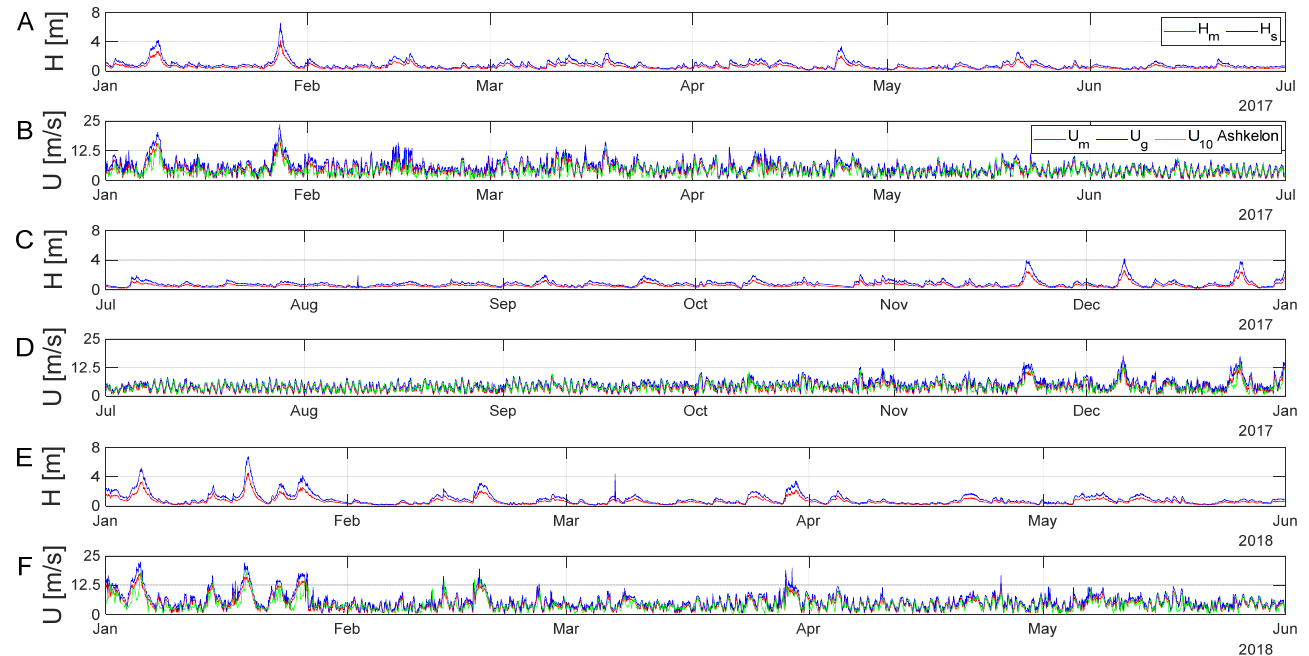
Figure 1. ( A ) 2017 January–June, significant and mean wave height hourly variations; ( B ) 2017 January–June, wind speed U, wind gusts and Ashkelon U 10 wind speed three hourly variations; ( C ) 2017 July–December, significant and mean wave height hourly variations; ( D ) 2017 July–December, wind speed U, wind gusts and Ashkelon U 10 wind speed three hourly variations; ( E ) 2018 January–May, significant and mean wave height hourly variations; ( F ) 2018 January–May, wind speed U, wind gusts hourly and Ashkelon U 10 wind speed three hourly